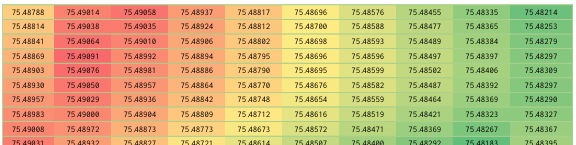
Table 1. Slopes of the fitting straight lines on the right image of the IKONOS dataset (degree)